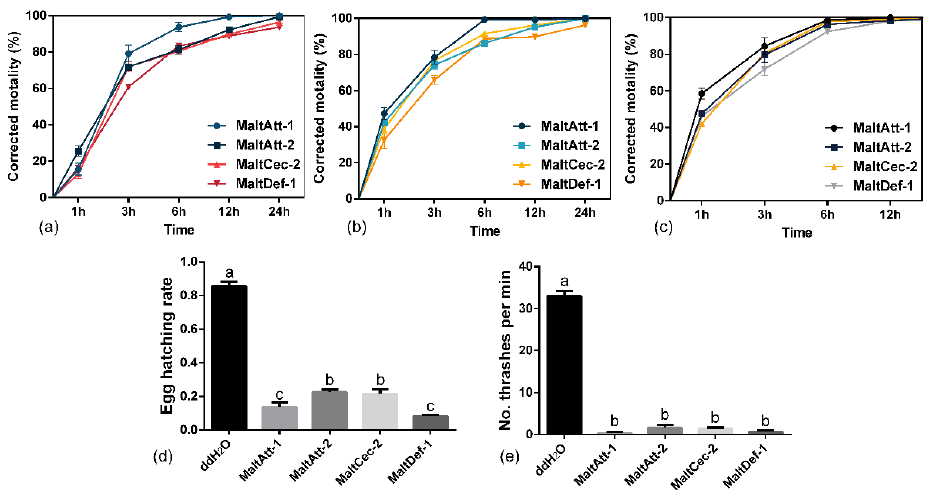
Figure 5. Bioassays with B. xylophilus . ( a ) Time–concentration–mortality trends of B. xylophilus treated with 0.3 mg · mL − 1 purified AMPs; ( b ) Time–concentration–mortality trends of B. xylophilus treated with 0.6 mg · mL − 1 purified AMPs; ( c ) Time–concentration–mortality trends of B. xylophilus treated with 1.0 mg · mL − 1 purified AMPs; ( d ) Egg hatching rate; ( e ) Thrashing frequency (times per min). Different letters (a, b, c, etc.) above bars denote values that are significantly different from each other ( p < 0.05, Tukey’s